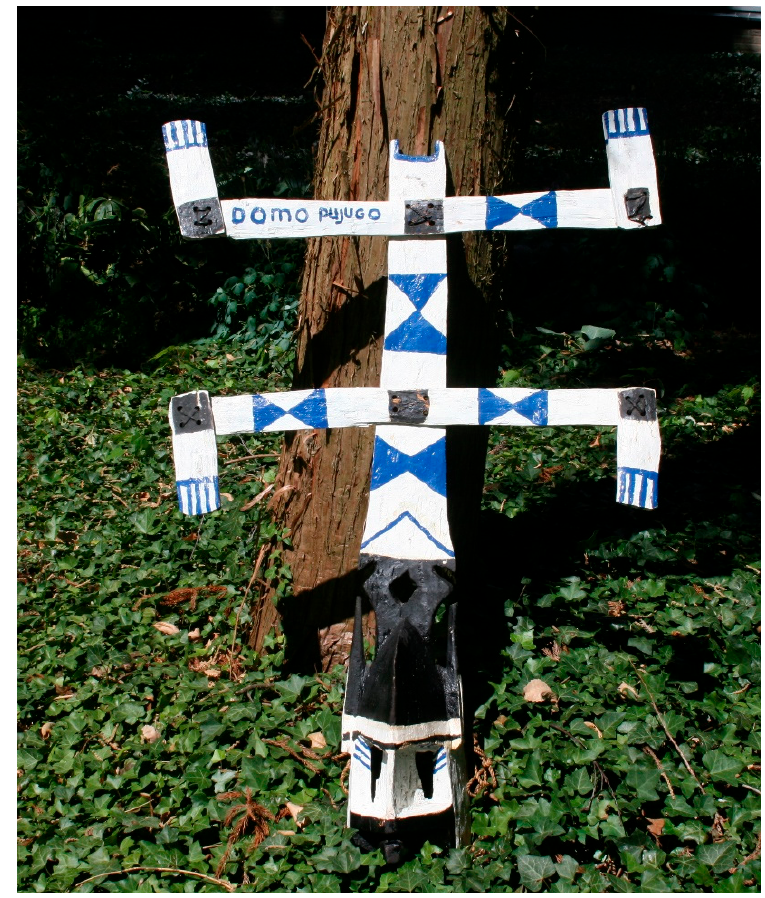
Figure 1. The mask of Domo Pujugo.